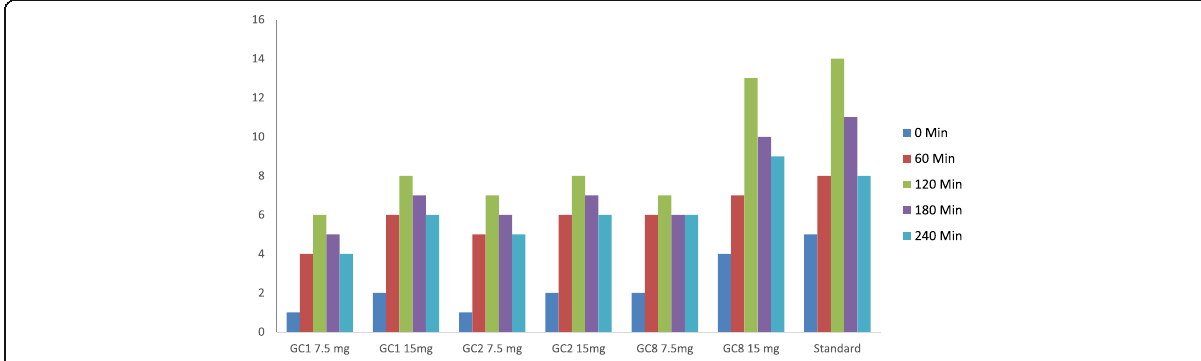
Fig. 2 Duration of catalepsy of Wistar rats on the seventh day of the